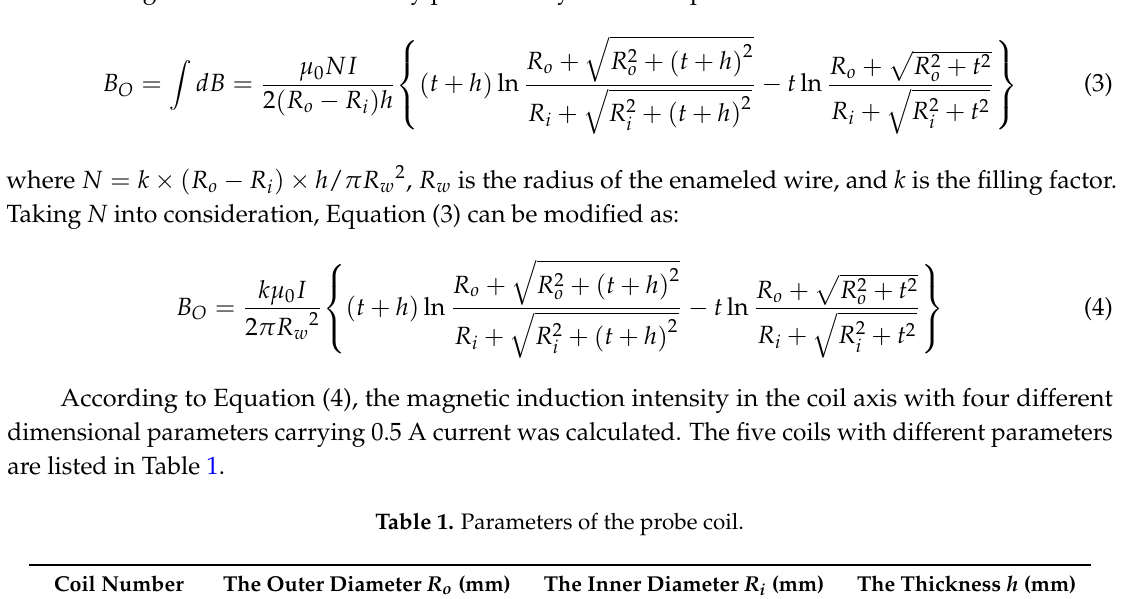
Table 1. Parameters of the probe coil.